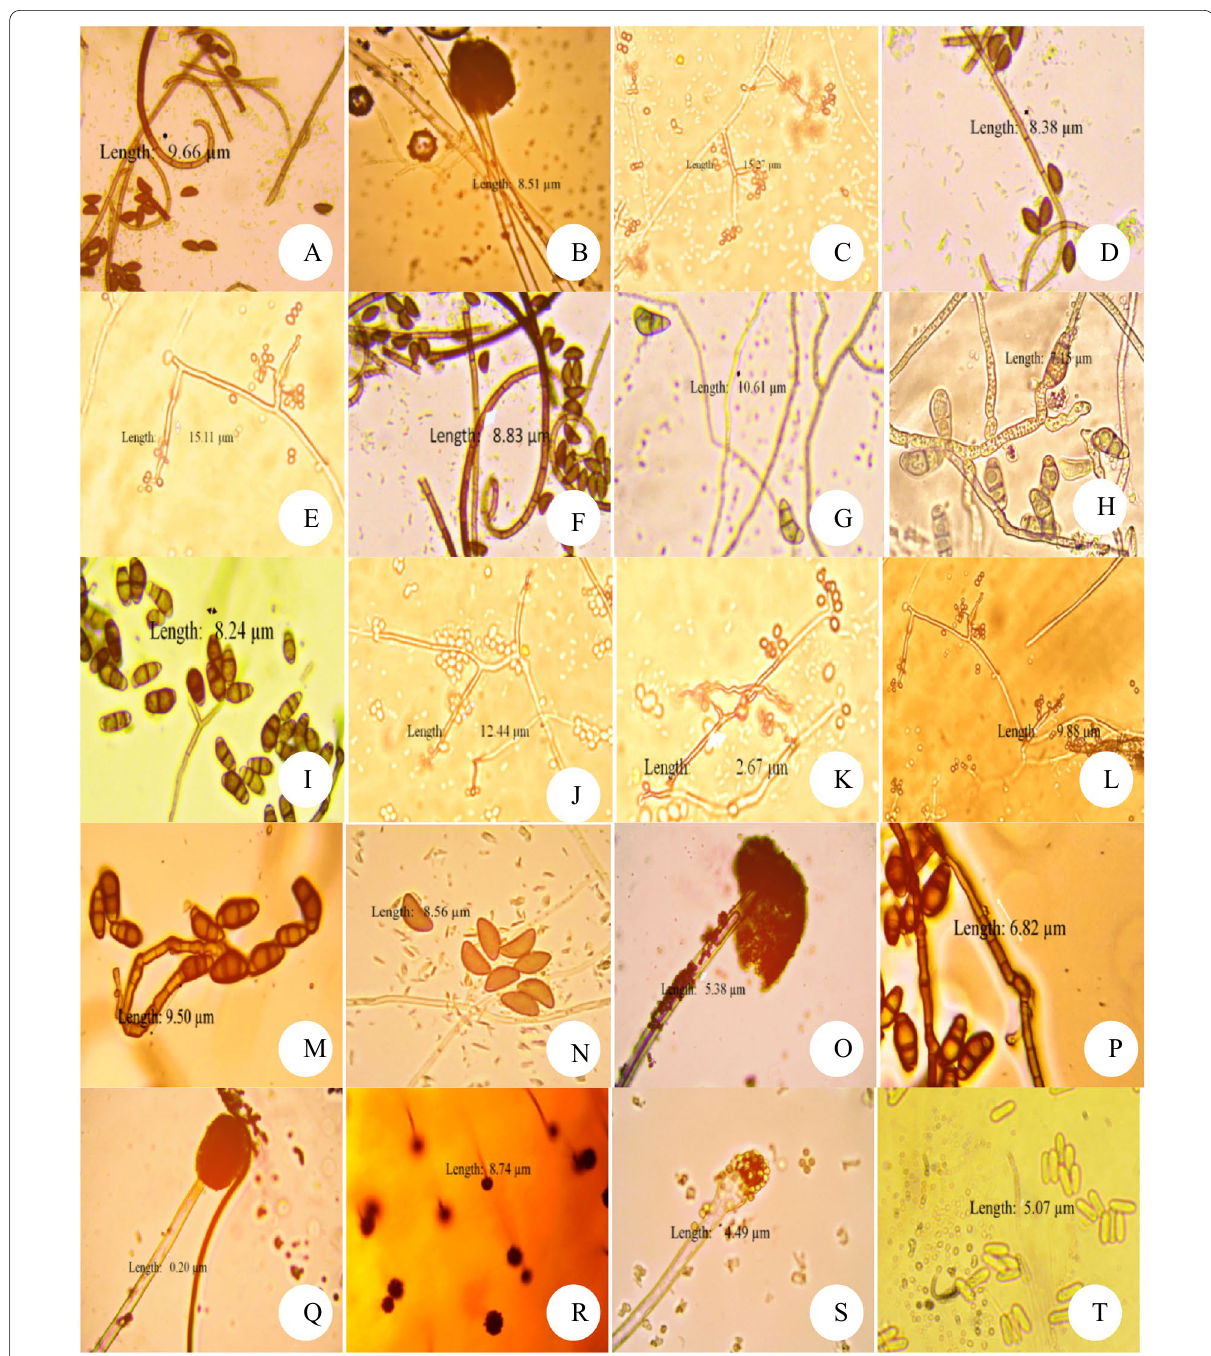
Fig. 3 Conidial and hyphal morphology of endophytic fungal species: Chaetomium sp. isolates of GaTpeOi ( A ), JgTjPr ( D ), PiCrPga ( F ), and CaCjPga ( M ); Aspergillus niger isolates of PsgTjPr ( B ), JgByU ( O ), and JaBuBys ( Q ); Beauveria bassiana isolates of JgSPK ( C ), JaGiP ( D ), JaSpkPGA(2) ( J ), JgCrJr ( K ), and JaTpOi(1) ( L ); Curvularia lunata isolates of JaGiPRB ( G ), CMTJP ( H ), JaMsBys ( I ), JaSpkPga(3) ( M ), and JgTgSr ( P ); Aspergillus flavus isolate of JgPWSR ( R ); Penicillium citrinum isolate of JaTpOi(2) ( S ); and Metarhizium anisopliae isolate of CaTpPga ( T